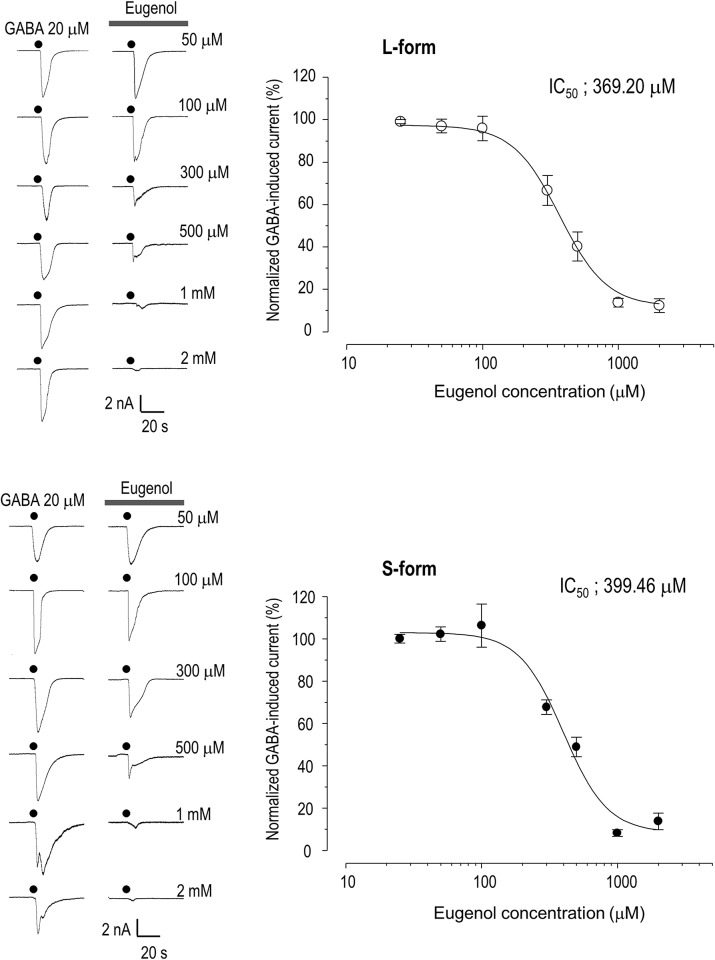
Dose-response curve for eugenol action on GABA-induced currents in HEK 293 cells with GABA receptors.Eugenol (50, 100, 300, 500, 1000, and 2000 μM) blocked the GABA (20 μM)-induced current in a dose-dependent manner. This blocking effect of eugenol on GABA-induced current was observed in HEK 293 cells transfected with the L- or S-form of the GABAA receptor. Data are expressed as mean 00B1 SEM.